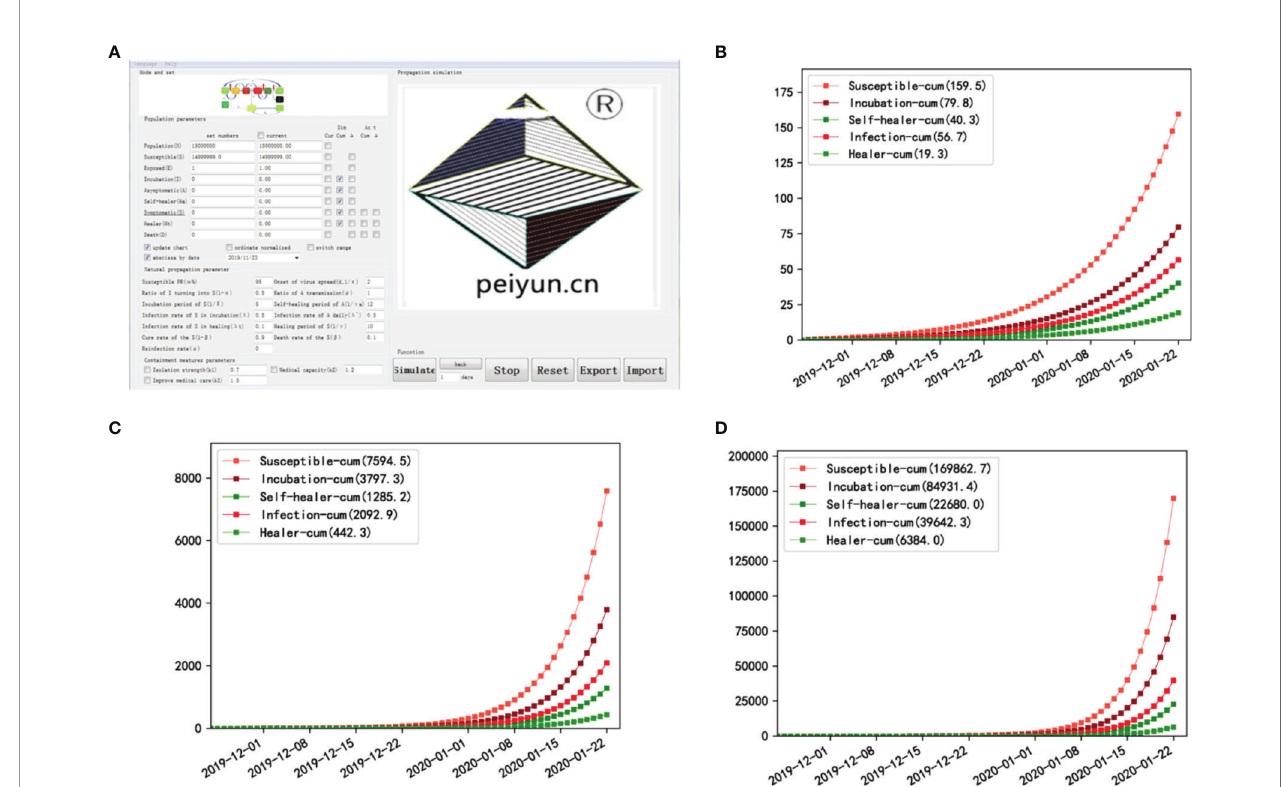
FIGURE 6 | Simulation of asymptomatic transmissibility shows its triggering effect. (A) Interface diagram after software startup. (B) Simulation data in Wuhan, China show that cumulative cases are 56.7 when there is no asymptomatic spread. (C) Simulation data in Wuhan when one-half of asymptomatic infection is spread. There will only 2,092.9 cumulative cases. (D) Simulation data in Wuhan when all the asymptomatic infection is spread. There will be several 10,000 cases, which may be the case [the present time (39,642.3) vs. the fi nal (approximately